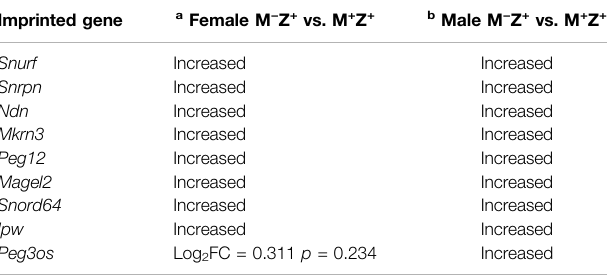
TABLE3| Theseimprintedgenesshowedsigni fi cantdifferenceintheirexpression levels in the female or male M − Z + embryos compared with those in the female or male M + Z + embryos of the same